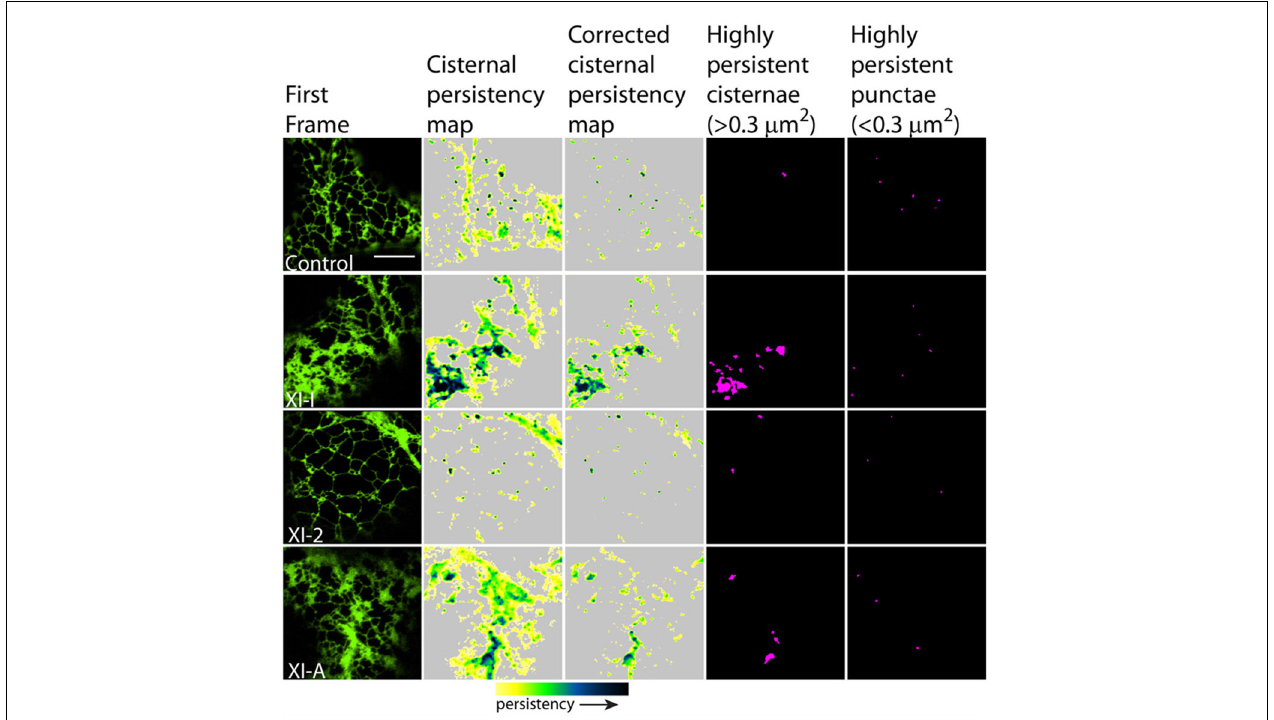
FIGURE 6 | Effects of XI-2, XI-A, and XI-I myosin tail domains on persistent ER cisternae and punctae identified with co-expressed GFP-HDEL. Left-hand panel is the first frame of a 50 frame movie. Middle two panels are cisternal persistency expressed as the sum of cisternae (morphometrically separated from tubules with a binary opening operation) that persist for at least five frames (7.9s). The corrected cisternal persistency subtracts out regions of continuous flow (sum of five frame differences). The